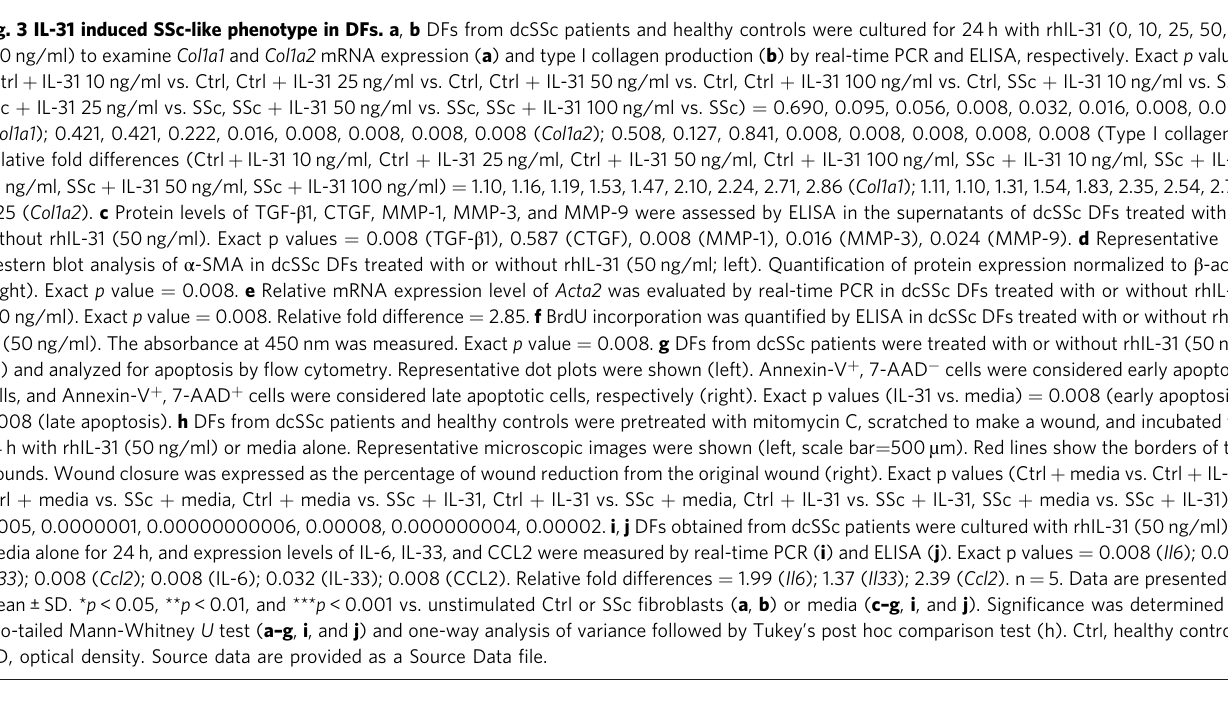
Fig. 3i, j, rhIL-31 signi fi cantly increased the expression of IL-6, IL-33, and CCL2 at both mRNA and protein levels in SSc DFs.